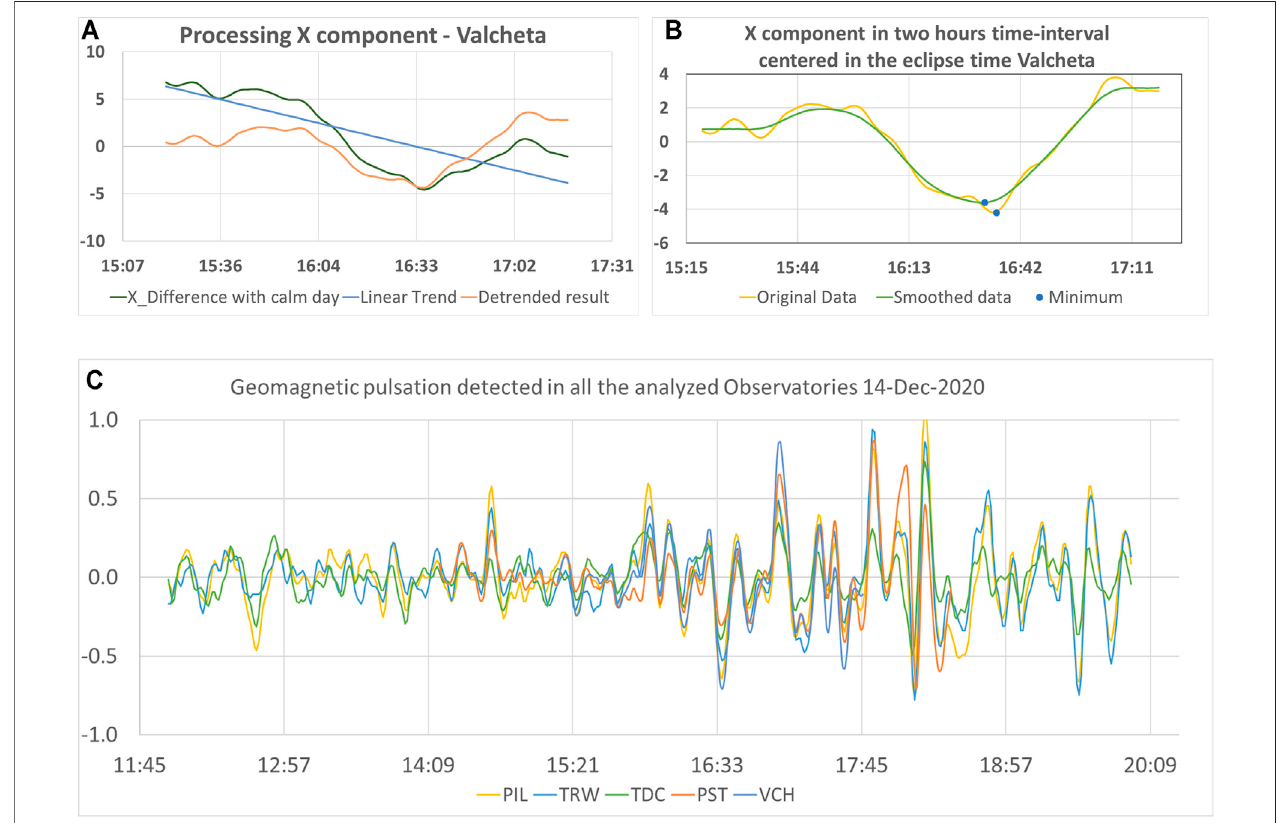
FIGURE 2 | Geomagnetic analysis: (A) A graphical example of detrending the curve obtained after taking difference between the eclipse day and the quiet day to getacleaneclipseeffect. (B) Exampleoftheeffectproducedbythenon-eclipse-relatedperturbationontheXcomponent. (C) Geomagneticpulsationdetectedinthe fi ve observatories analyzed, verifying that the perturbation noticed in (B) is not related to the eclipse effect. All vertical axis are in nT and the horizontal axis in UT.